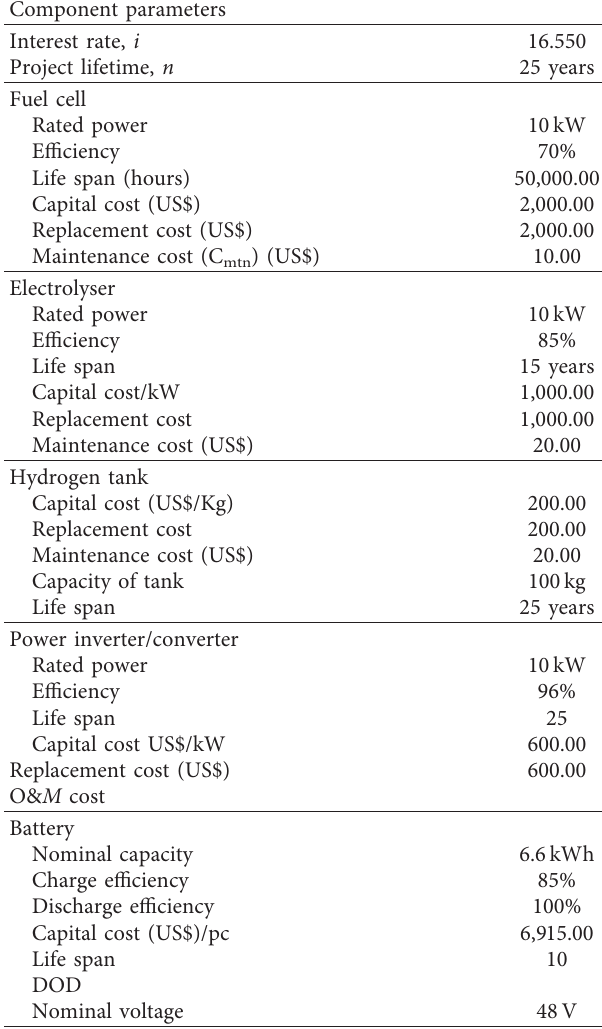
Table 2: HRES component parameters.